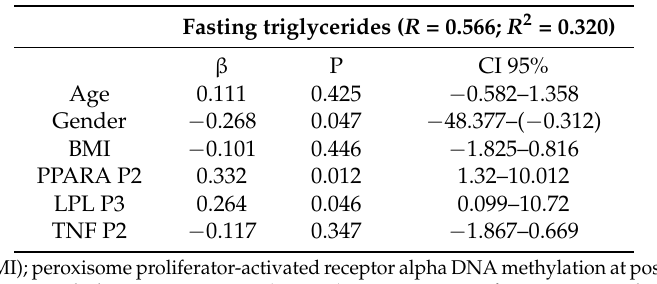
Table 5. Lineal regression analysis with fasting triglycerides as dependent variable and PPARA P2, LPL P3, and TNF P2 as independent variables and corrected for age, gender and BMI.